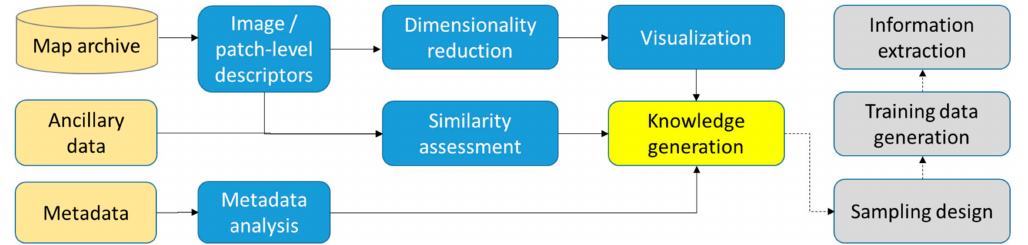
Figure 3. The methodology for metadata analysis of and content-based knowledge generation from map archives to facilitate information